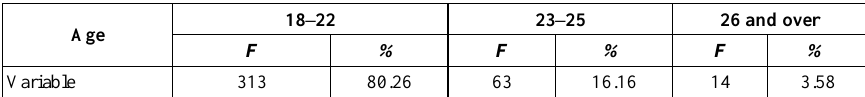
Table 3. Distribution of university students by